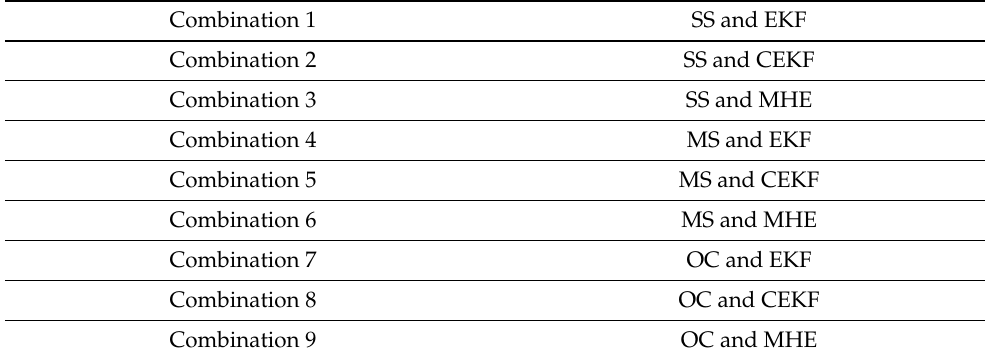
Table 7. Combination of estimators and NMPC methods considered in the analysis.